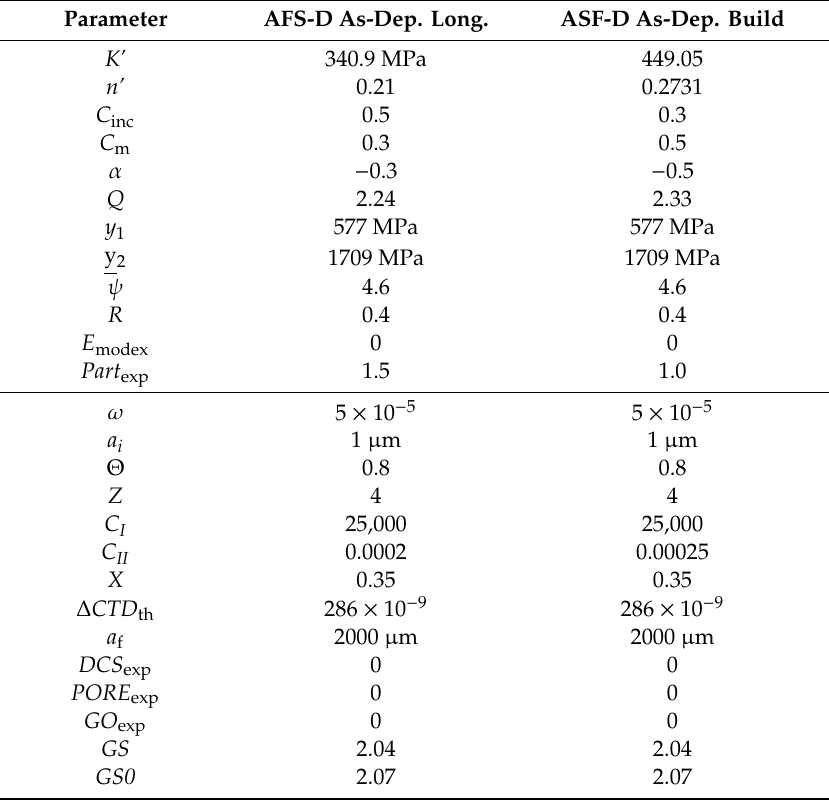
Table 3. MSF parameters for each data